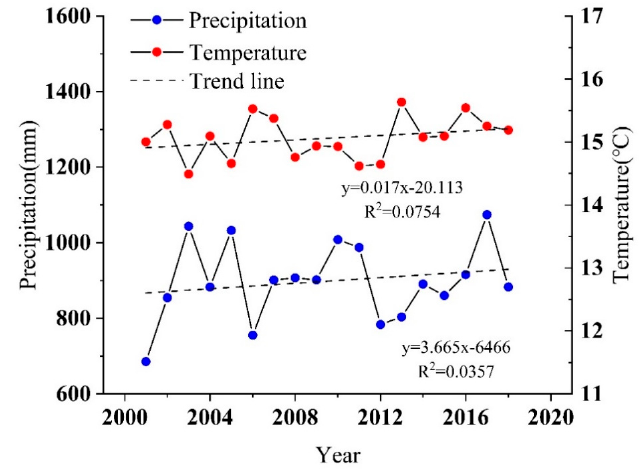
Figure 8. The trends of the precipitation and temperature.